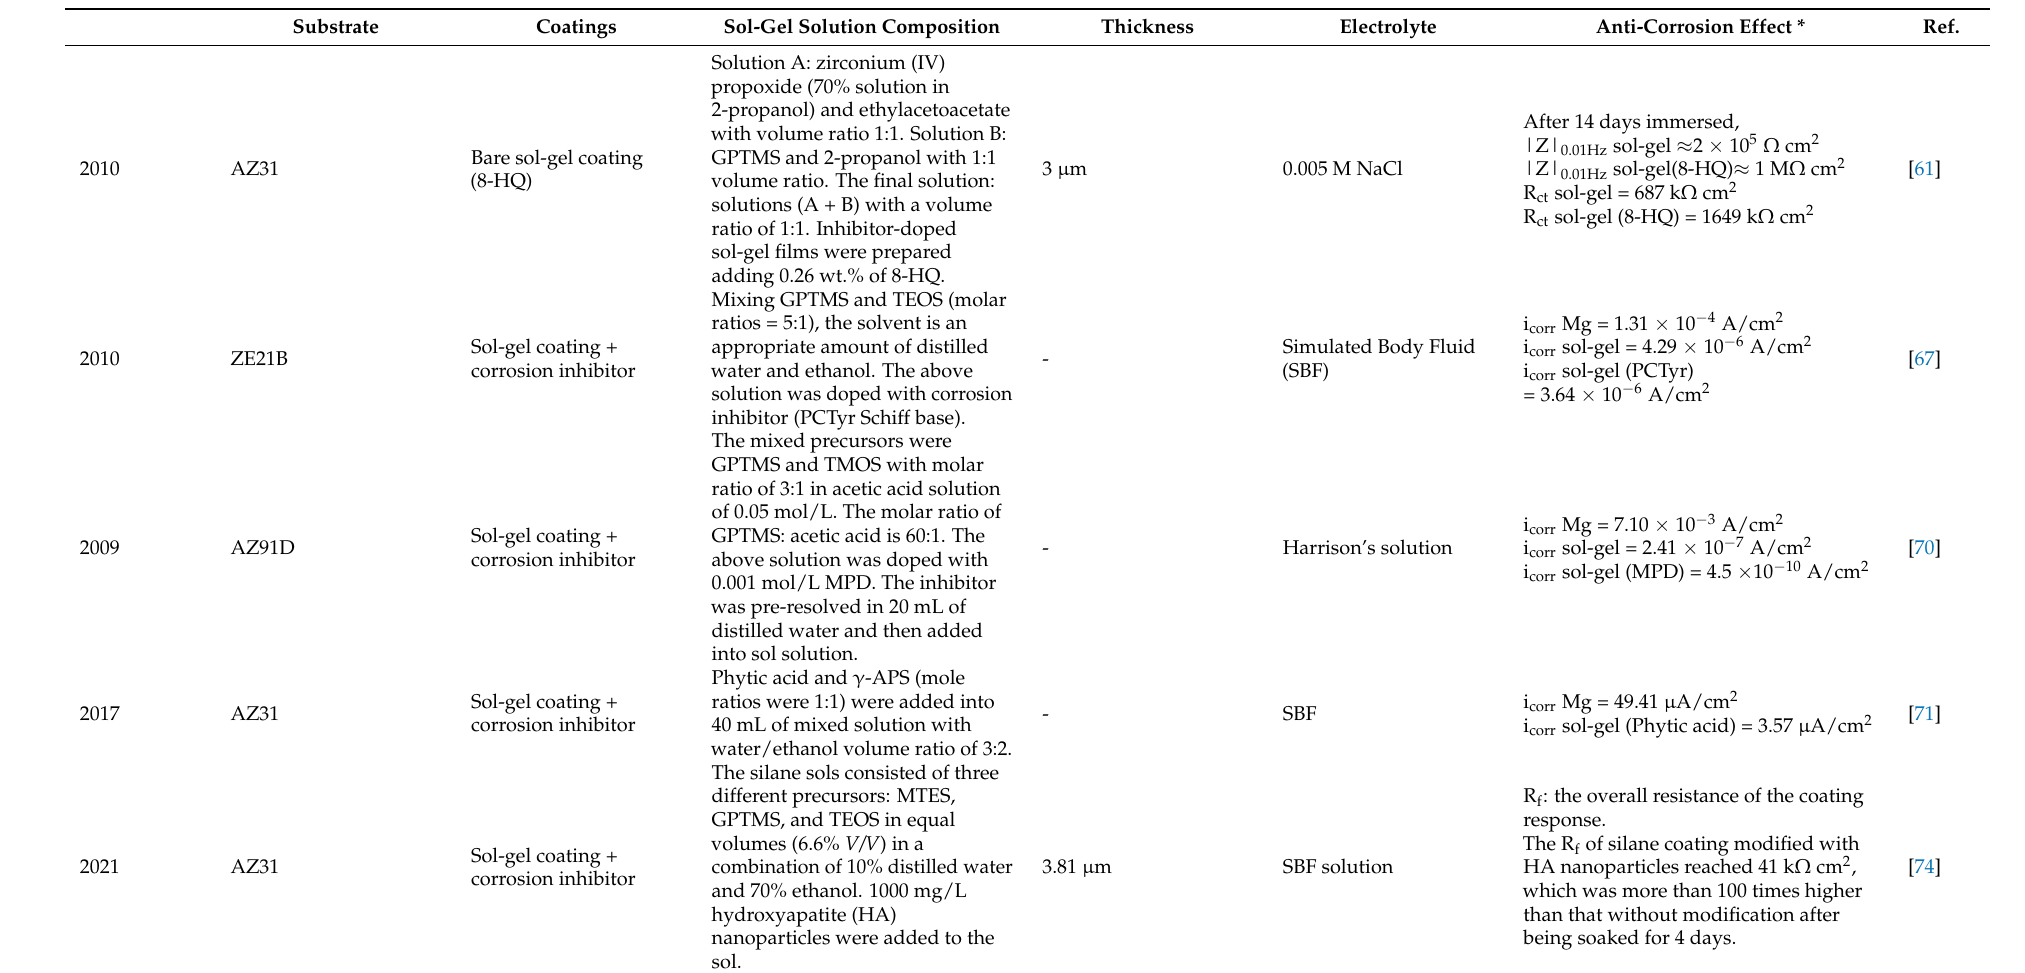
Sol-gel coating + corrosion